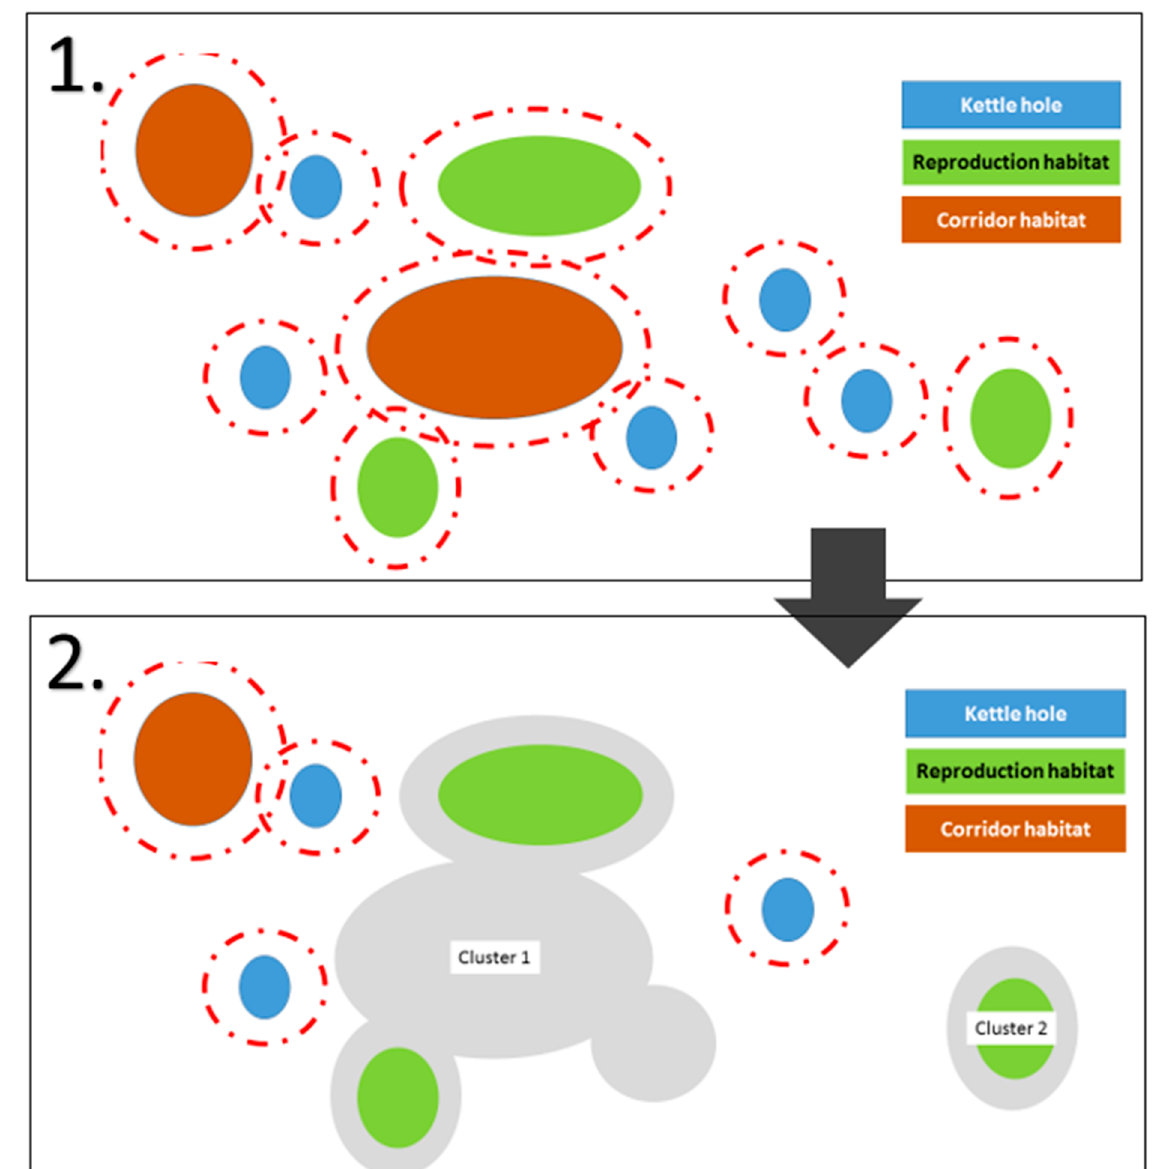
Figure 2. The applied clustering approach, where kettle holes (blue), other reproduction habitats (green), and corridor habitats (brown) were assigned buffers corresponding to half of the indicator species’ range (1). Where buffers overlapped, habitats were combined into a cluster. Only clusters containing at least one reproduction habitat were considered (2).